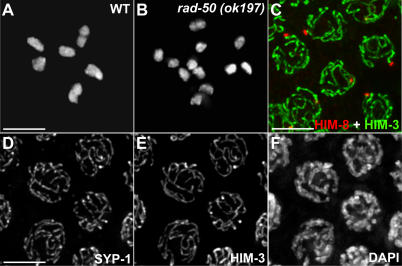
RAD-50 Is Required for Chiasma Formation but Not for Homolog Pairing and Synapsis(A, B) Each panel shows the full karyotype in a single oocyte nucleus at diakinesis, the last stage of meiotic prophase. The wild-type nucleus (A) contains six DAPI-stained bodies, corresponding to the six pairs of homologous chromosomes (bivalents) attached by chiasmata, whereas the rad-50 mutant nucleus (B) contains 12 separate DAPI-stained chromosomes (univalents), indicating a lack of chismata connecting homolog pairs.(C) Pachytene nuclei from the rad-50 mutant stained with antibodies detecting X-chromosome pairing center-binding protein HIM-8 and chromosome axis protein HIM-3. A single HIM-8 focus (or two closely spaced HIM-8 foci) is seen in each nucleus, indicating successful homologous pairing.(D–F) Pachytene nuclei from the rad-50 mutant, showing coimmunolocalization of SC central region protein SYP-1 and meiotic chromosome axis protein HIM-3 at the interface between parallel tracks of DAPI-stained chromatin, indicating successful assembly of the SC. Scale bar = 5 μm.